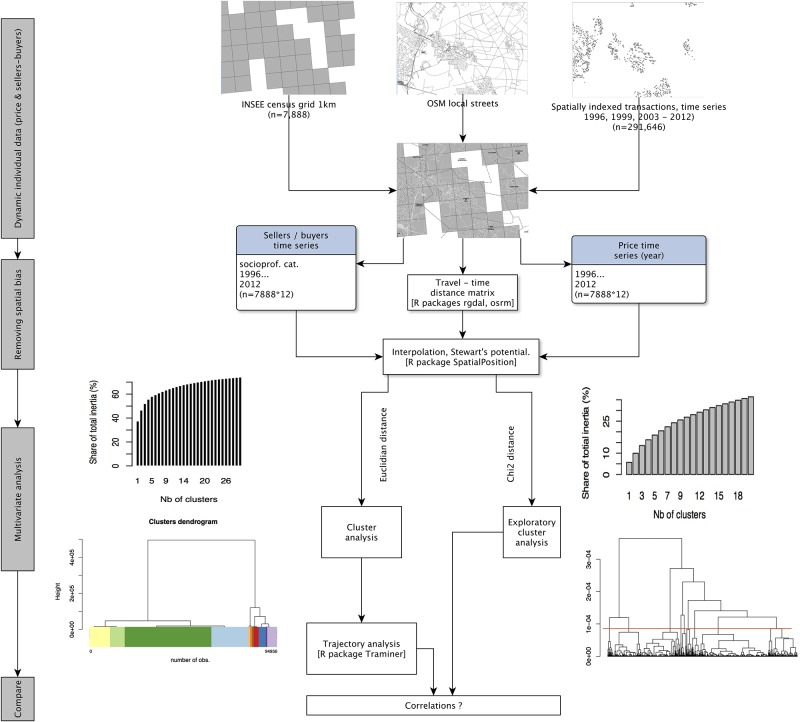
Data-flow diagram.